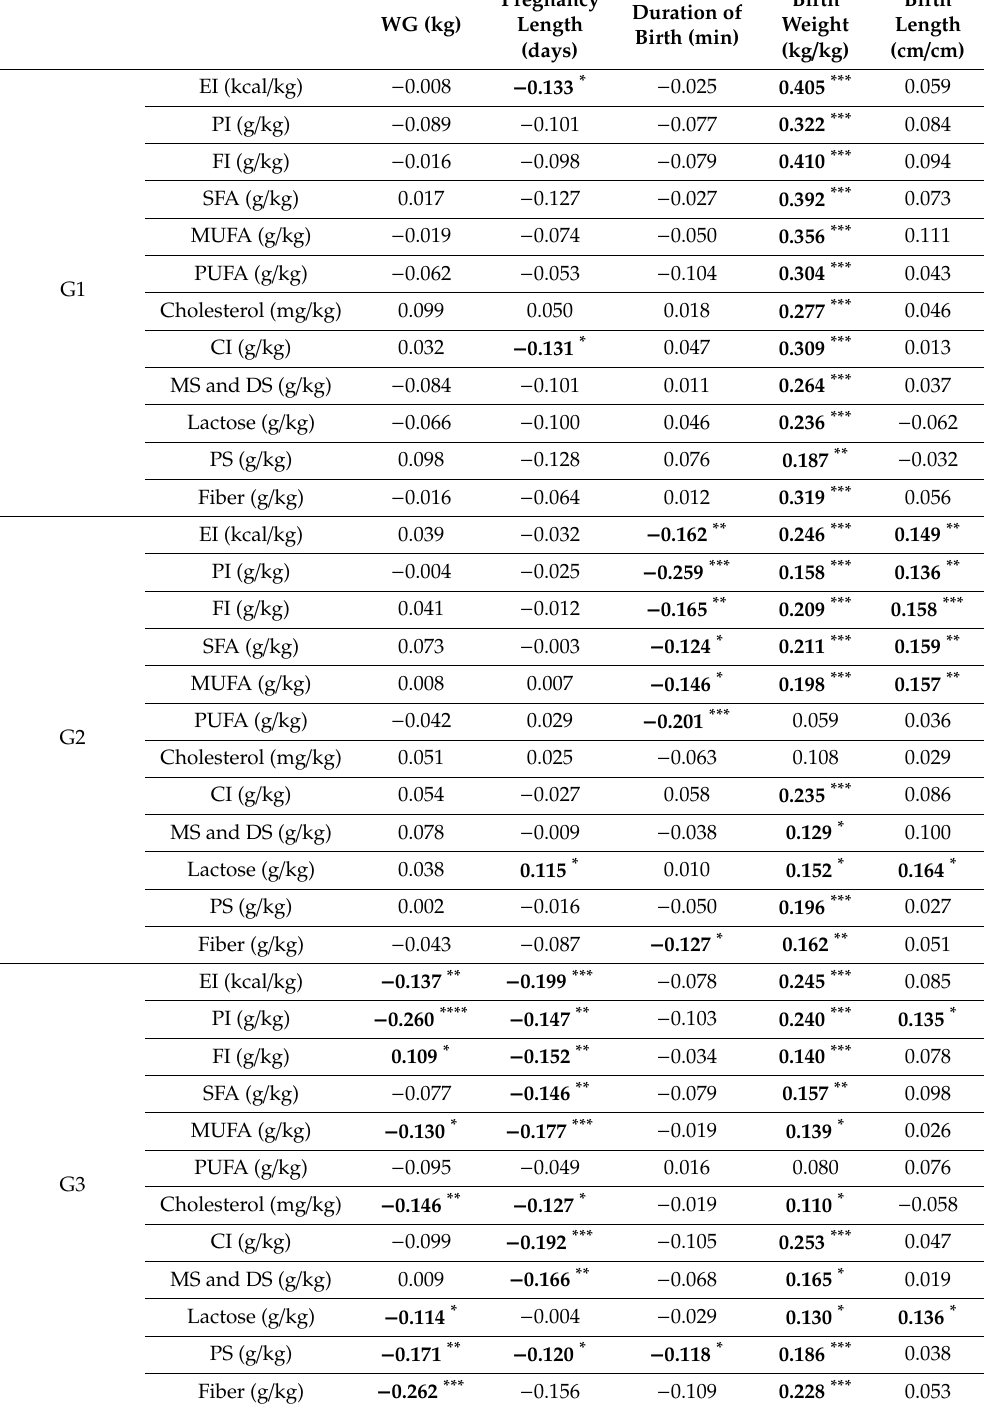
Table 4. Correlation analysis of energy and macronutrients intake and parameters of pregnancy